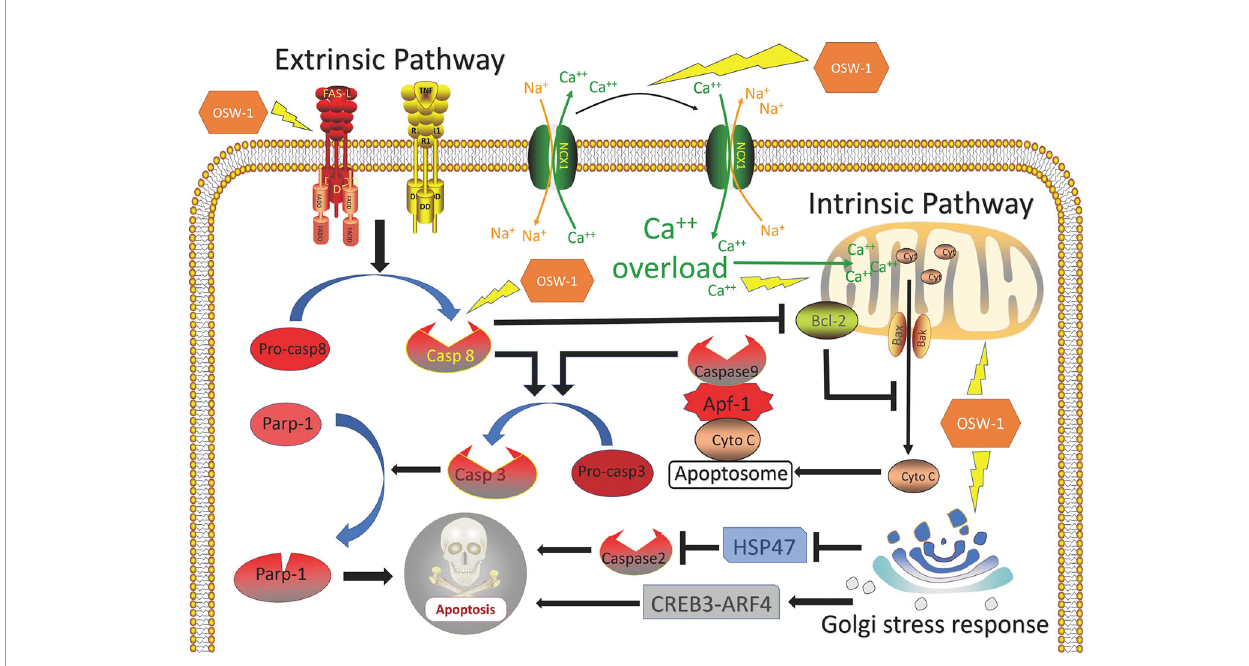
FIGURE 2 | Overview of mechanisms of apoptosis induced by OSW-1 in cancer